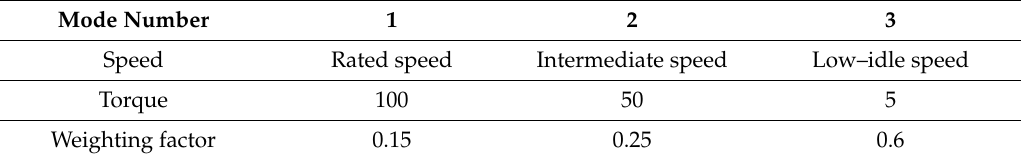
Table 3. Non-road emission gas measurement method (ISO 8178 F